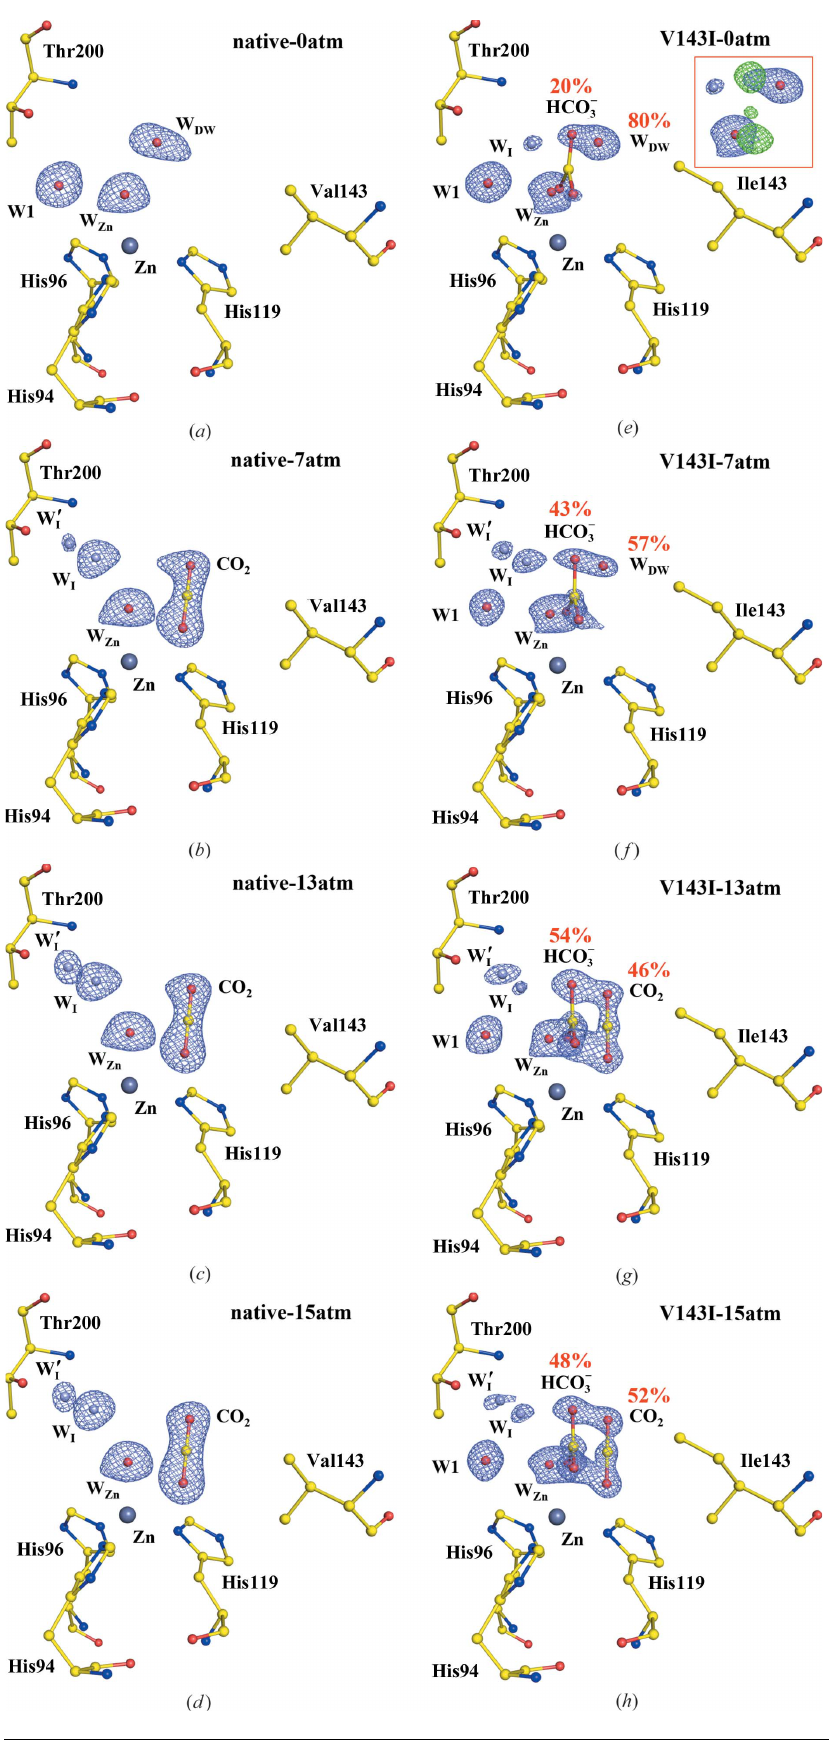
Figure 2 CO 2 /HCO 3 (cid:2) -binding site of native and V143I CA II. The intermediate waters (W I and W I 0 ) are coloured steel blue for clarity. The electron density (2 F o (cid:2) F c ) is contoured at 1.5 (cid:2) where not indicated otherwise. ( a )–( d ) Native CA II structures. ( e )–( h ) V143I CA II structures. W I 0 at 7, 13 and 15 atm is contoured at 1.25 (cid:2) and W I at 0 atm is contoured at 1.0 (cid:2) . Partial occupancies of HCO 3 (cid:2) and W DW were determined in V143I-0atm and V143I-7atm, and partial occupancies of HCO 3 (cid:2) and CO 2 were determined at the higher